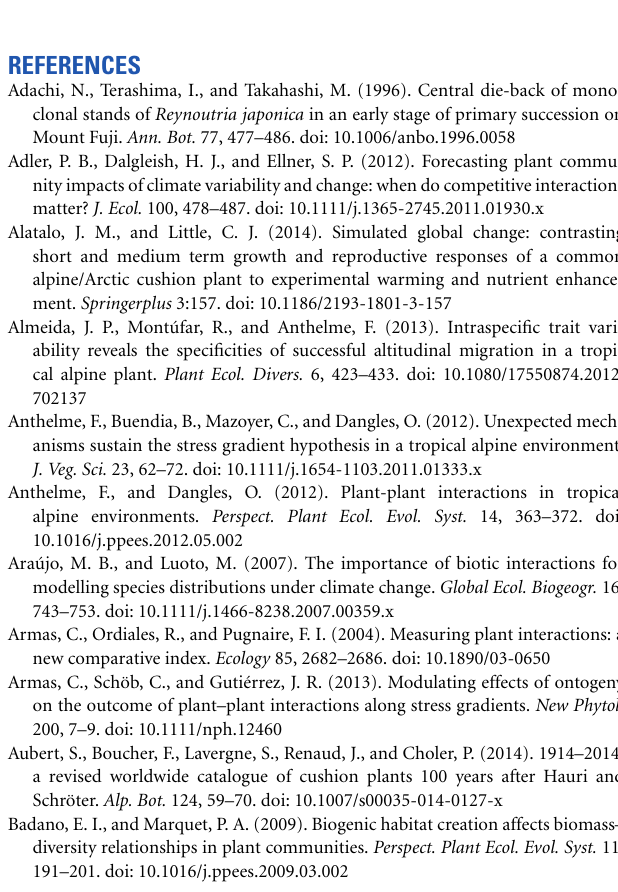
during the day; (B) A. aretioides increases minimum temperature at night (unpublished data; Thermographic System VarioCAM® hr—head 680/30mm